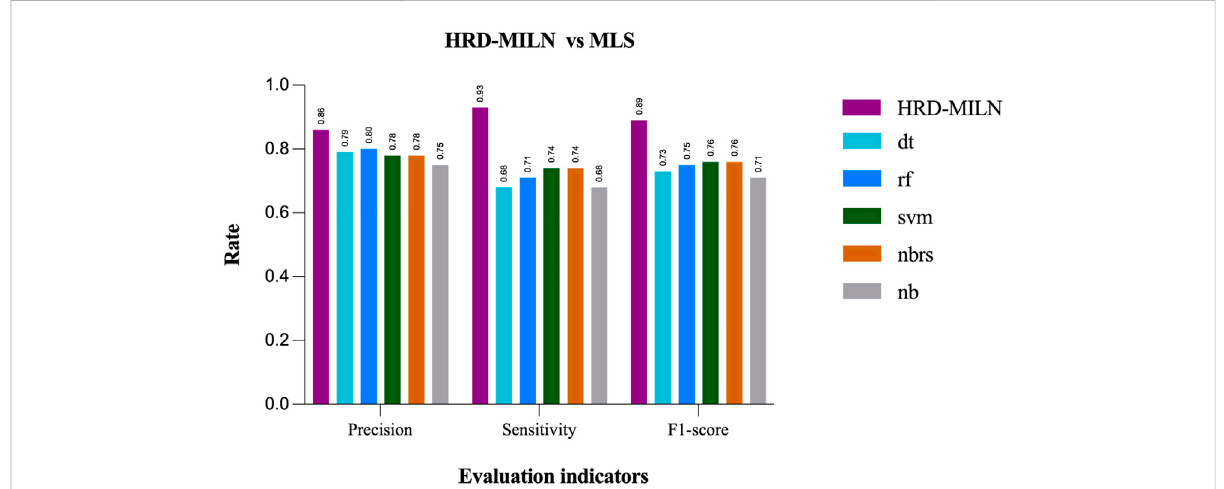
FIGURE 6 The performances of MILS and HRD-MILN in whole-exome sequencing samples. HRD-MILN had the highest scores (precision 0.86, sensitivity 0.93, F1-score 0.89) than MILS on each Evaluation indicator. Abbreviations: MLS: machine learnings, dt: DecisionTree. rf: Random Forest. svm: Support Vector Machine. nbrs: KNeighbors. nb: